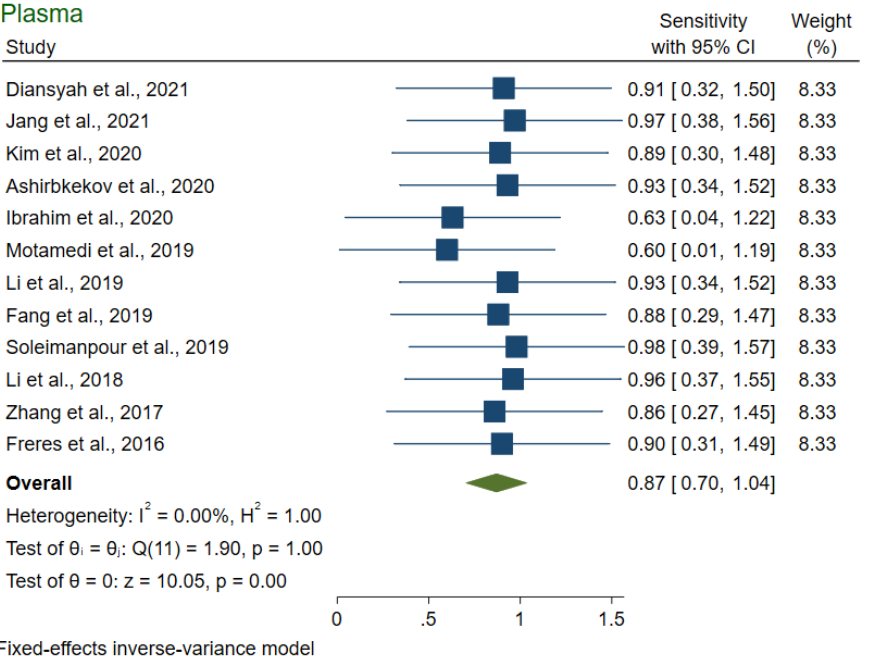
Fig. 6. Sensitivity of circulating microRNAs on plasma